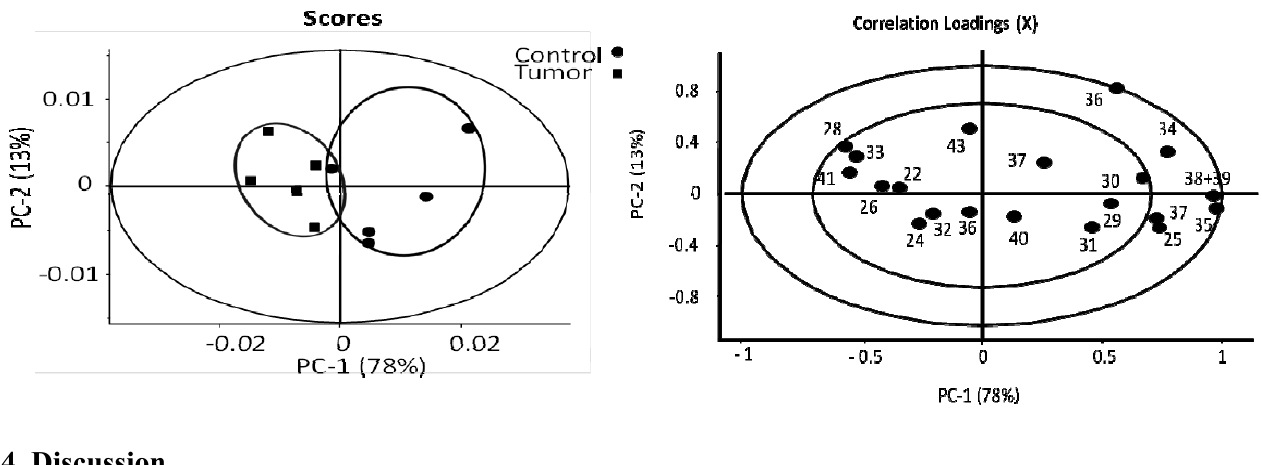
Figure 6. PCA analysis of the estimates of the absolute concentrations of the water soluble metabolites (hydrophilic metabolites) from liquid state 1 H-NMR. Metabolites are labeled using the same numbers as in Figure 3. The positive correlation loading in PC-1 indicates decreased concentrations of 29 (succinate) and 38 + 39 ( α , β -glucose); and negative PC-1 correlation loadings: 26 (alanine), 28 (glutamate), 33 (creatine), and 41 (fumarate) with increased concentrations. Melanoma and control could be separated in two groups in the score diagraph. (number of samples in model) N = 10, (number of variables) K = 20, (number of latent components) A = 7, (model fit) R 2 = 0.91, (predictive ability) Q 2 = 0.89. The insider circle with radius r = 0.5, the outer one r =